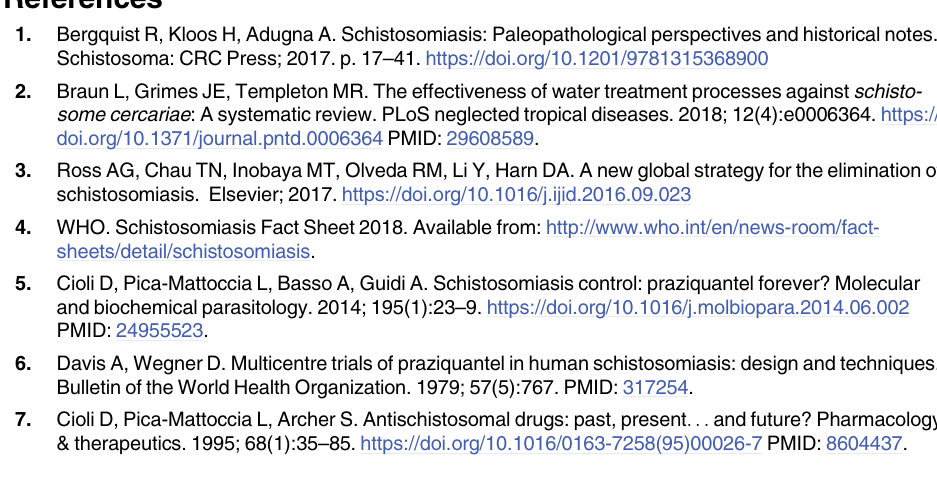
S7 Table. Oligonucleotides used in the construction of S . pombe